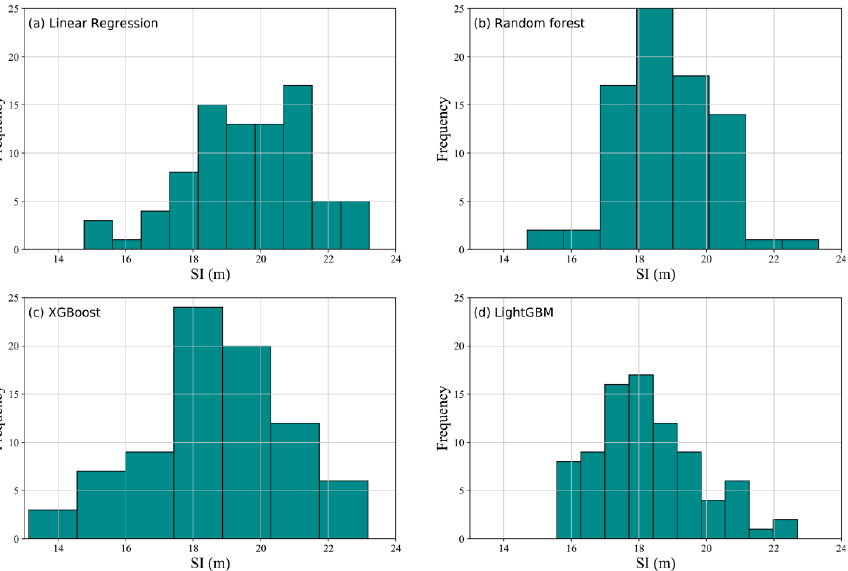
Figure 5. Frequency histogram of predicted SI for the four models using climatic and soil chemical variables.